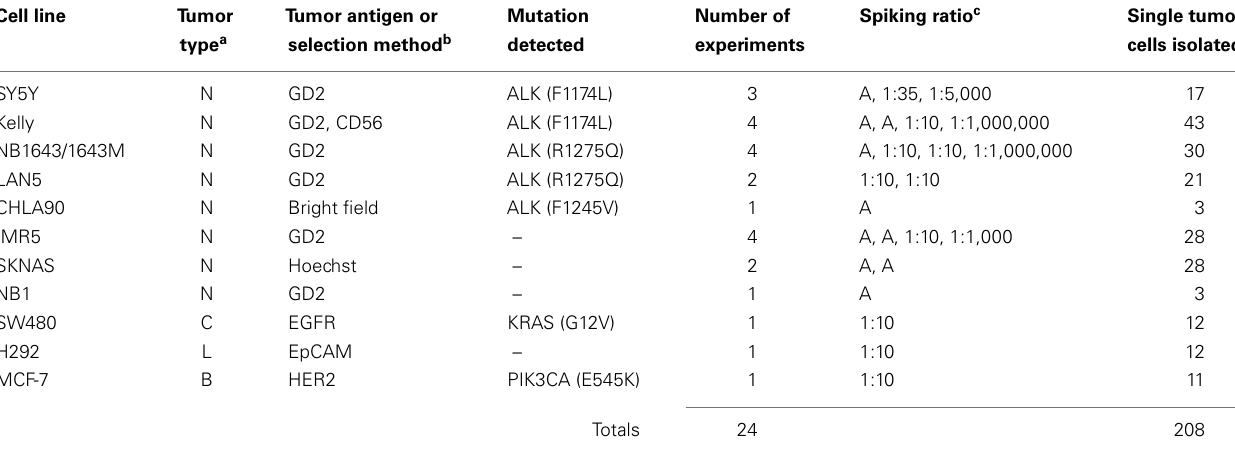
Table 1 | Summary of single cells collected from cell line experiments